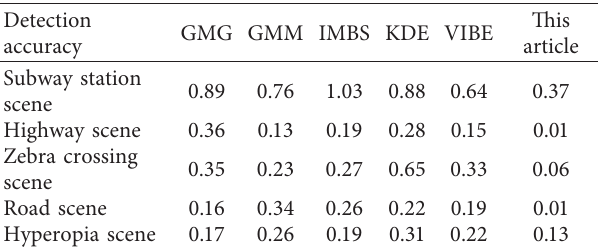
Figure 10: Recall rate index graph for camera shake video library scene detection. Table 10: Data of speed indicators for camera shake video library scene detection.